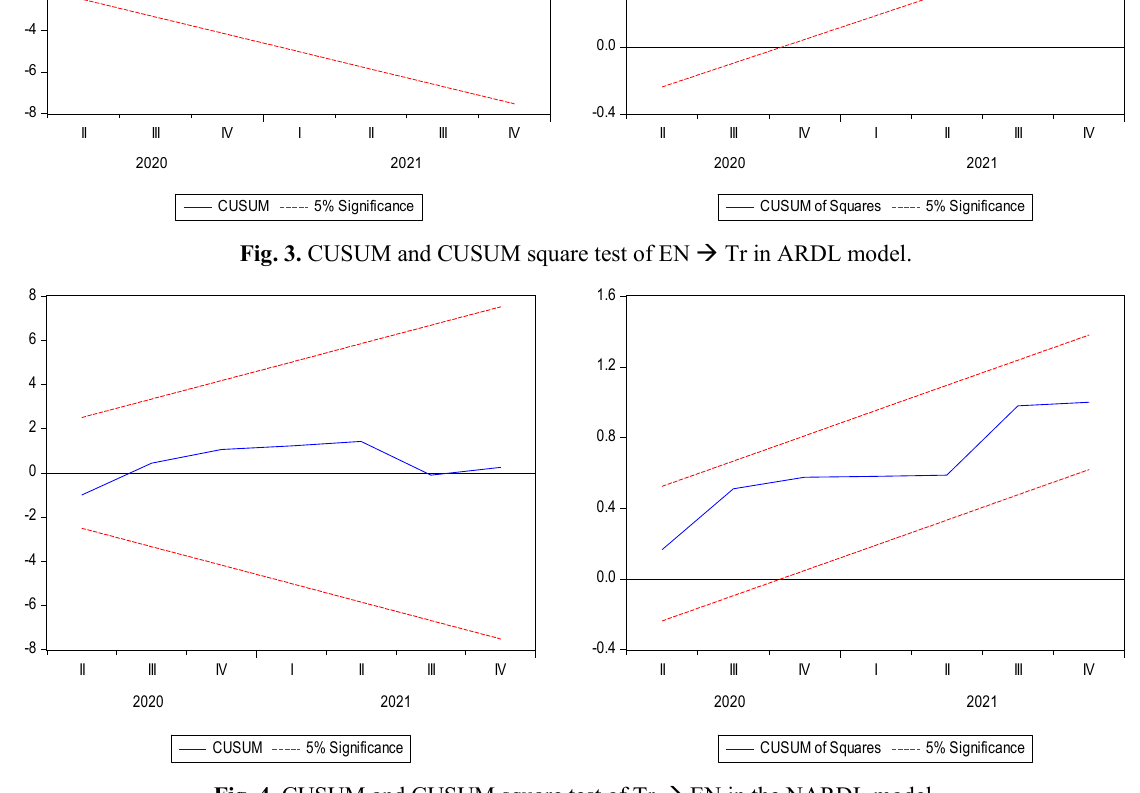
Fig. 4. CUSUM and CUSUM square test of Tr  EN in the NARDL model.